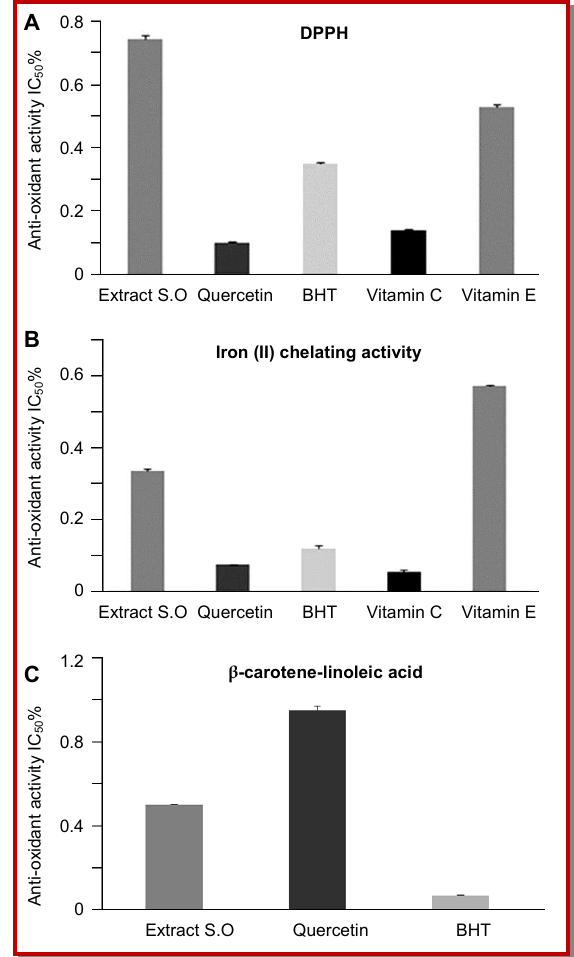
Figure 2: Anti-oxidant activity of S. officinalis extract by DPPH (A), Iron (II) chelating activity (B) and β -carotene/ Linoleic Acid Bleaching assay (C). Each value represents a mean ± SD (n =